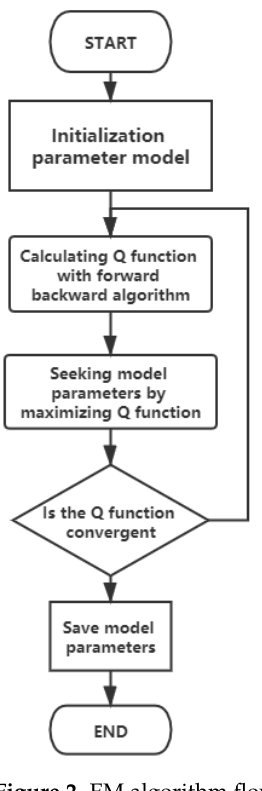
Figure 2. EM algorithm flow